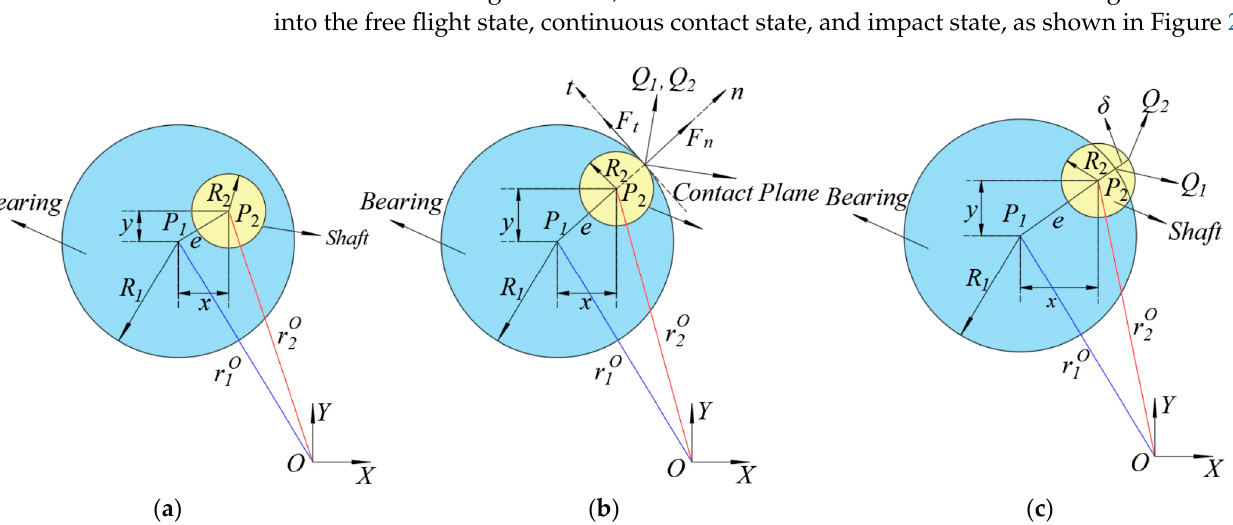
Figure 1. Clearance model of a revolute pair.